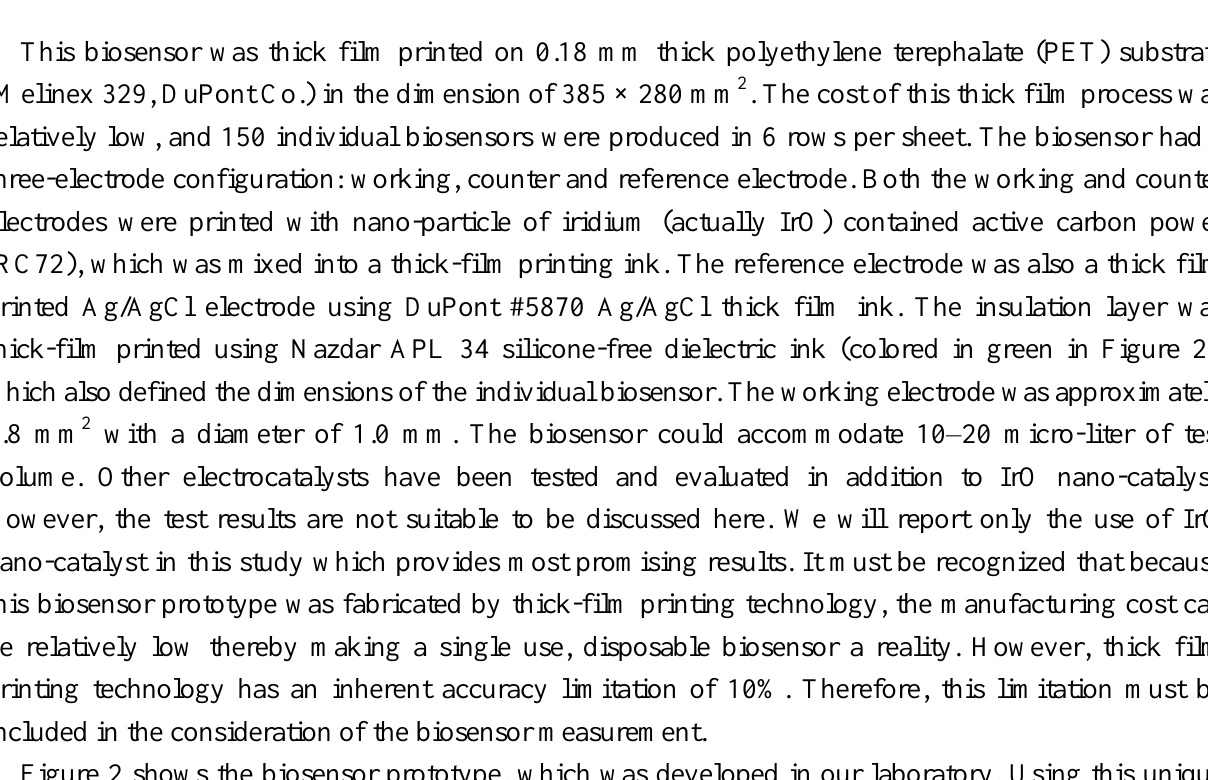
Figure 1. Pathway from Pristanic Acid to Pristanoyl-CoA then to producing H